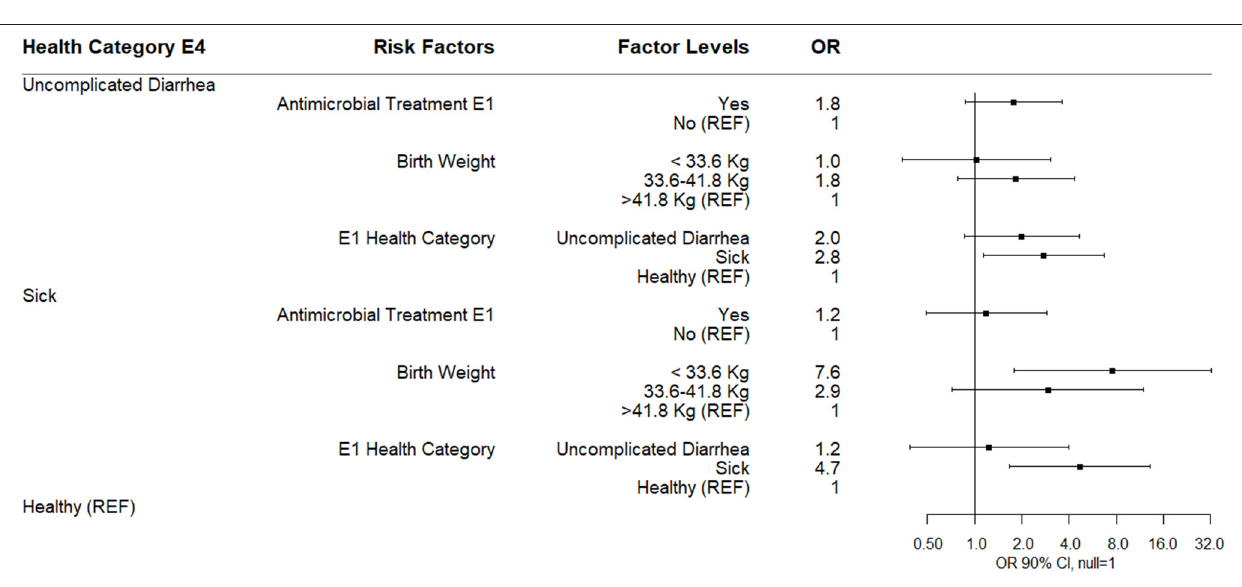
FIGURE 7 | Results of multinomial logistic regression modeling health category at sampling day E4. Odds ratios and 90% confidence intervals are